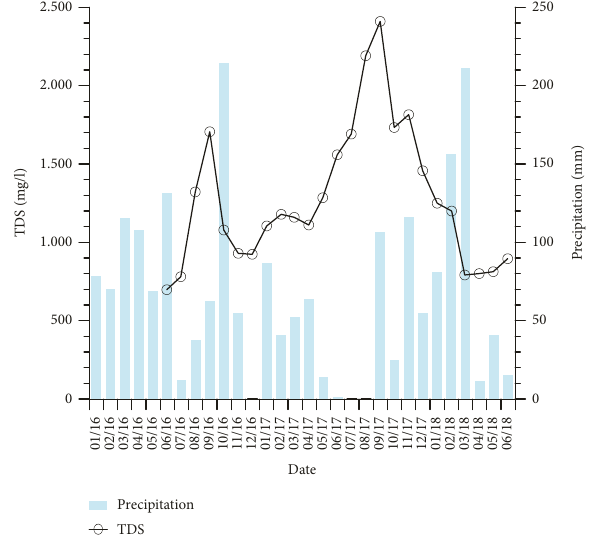
Figure 8: Monthly average values of TDS in Sobranska blatina and precipitation on the island of Mljet calculated from diurnal observations.